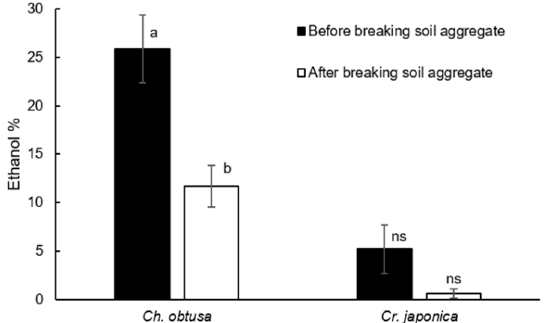
Figure 6. Soil water repellency (SWR) intensity of broken soil aggregates at 5 cm soil depth of Ch. obtusa and Cr. japonica intact tree plots. Small letters and ns denote significant and non-significant differences, respectively.